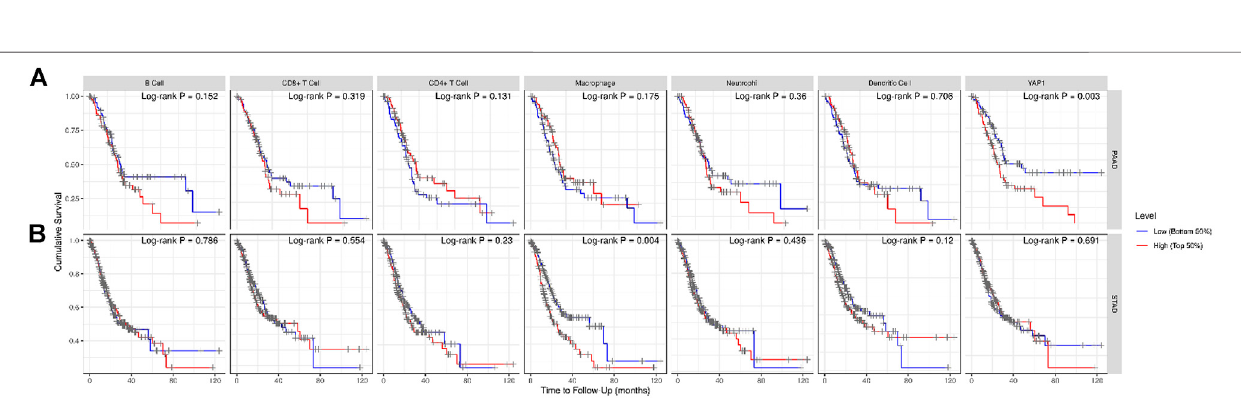
Frontiers in Molecular Biosciences |